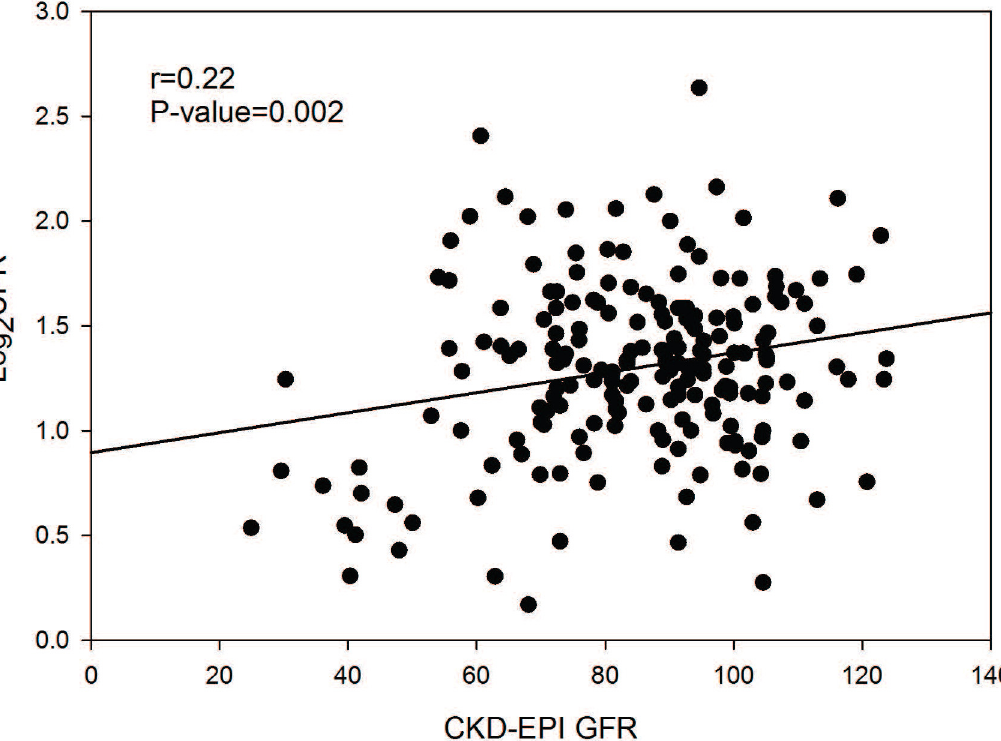
Fig 1. Linear Regression of CFR and eGFR. Coronary flow reserve (CFR) was log transformed. Estimated glomerular filtration rate (eGFR) was determined using the Chronic Kidney Disease Epidemiology Collaboration (CKD-EPI) equation.